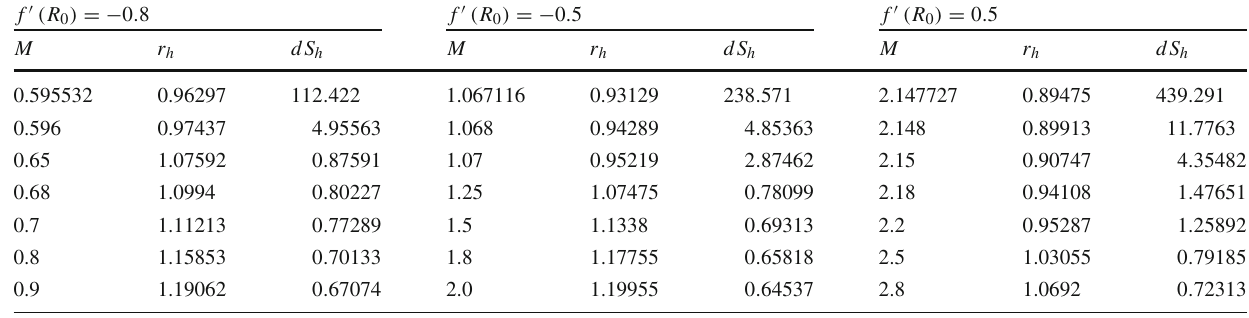
Table 3 The relation between